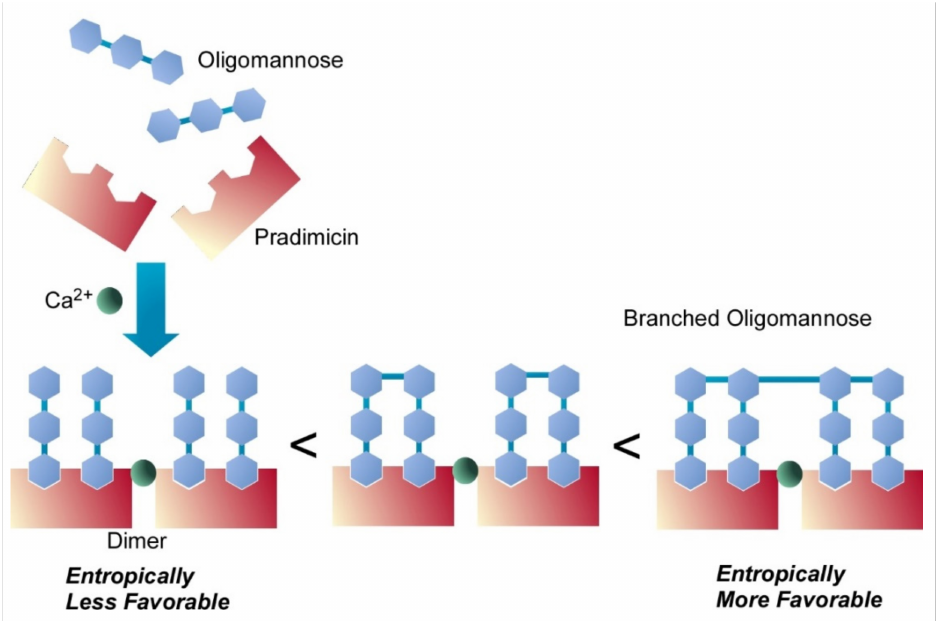
Figure 4. Entropically favorable binding of a branched oligomannose to dimerized pradimicins through binding with Ca 2+